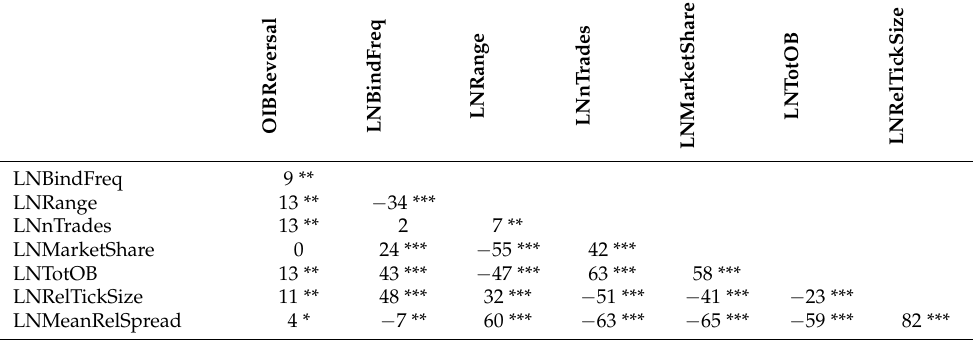
Table 3. Correlation matrix for the regression variables with intraday coefficients calculated with one minute intervals